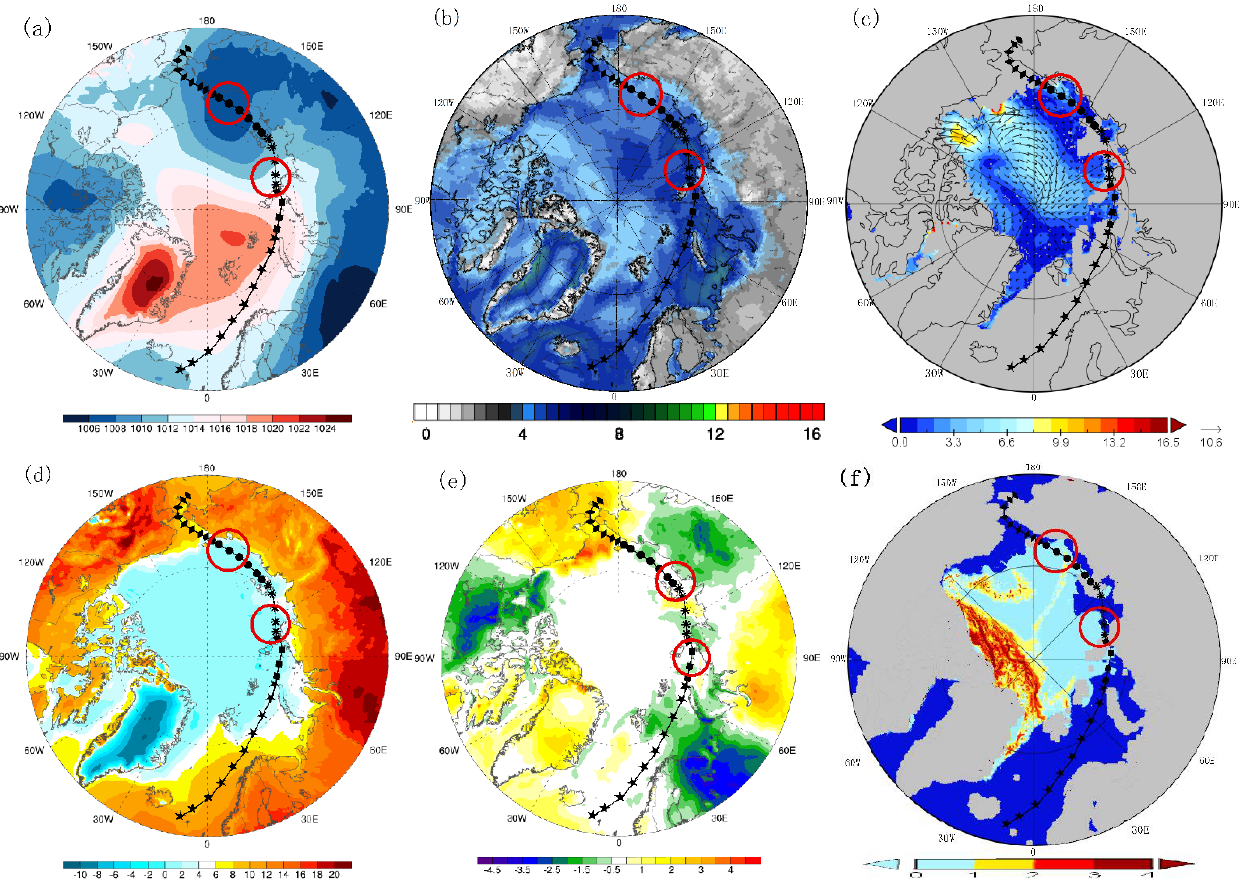
Figure 16. Distribution map of ( a ) sea level pressure (unit: hpa); ( b ) wind field (unit: m − 1 ); ( c ) sea ice movement (unit: m −1 ); ( d ) temperature (unit: centigrades); ( e ) temperature anomaly (unit: centigrades) and ( f ) sea ice age (unit: year) in the Arctic summer in July 2019. (The red circles represent the special areas.)